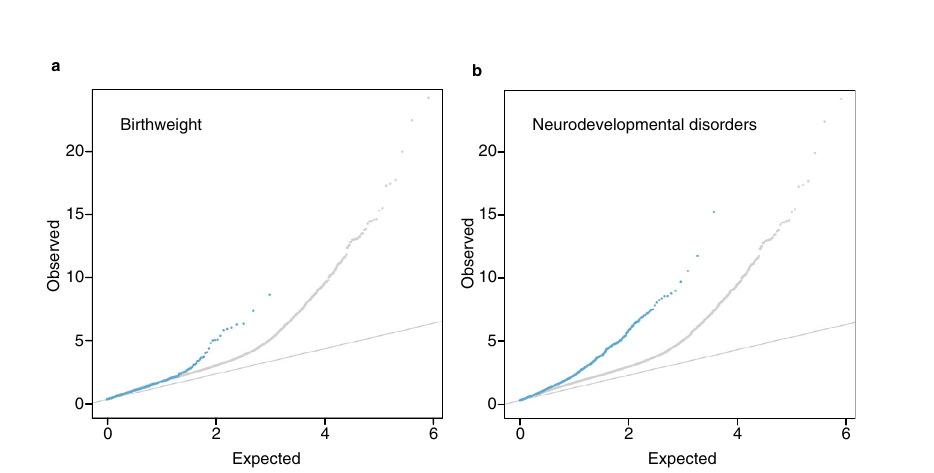
Fig. 7 Differences in DNA methylation between fathers and mothers of naturally conceived and ART-conceived children at the BRCA1-NBR2 locus. In panels ( a – c ), each dot represents the coef fi cient from the regression of DNA methylation on ART-conceived vs naturally conceived newborns, and the vertical bar represents the 95% con fi dence interval. The region shown is chr17:41277059-41278906 (hg19). a 969 fathers for ART-conceived children, 980 fathers for naturally conceived children were examined. The adjusting variables were paternal age, paternal smoking, and paternal BMI. b 970 mothers for ART conceived children, 986 mothers for naturally conceived children were examined. The adjusting variables were maternal age, maternal smoking, maternal BMI before pregnancy, and parity. c 962 ART conceived and 983 naturally conceived newborns were examined. The adjusting variables were maternal age, maternal smoking, maternal BMI before pregnancy, child sex, parity, and plate ID. d The BRCA1 - NBR2 bidirectional promoter showing transcription start and orientation, CpG island (green) and epigenetic marks (purple) representing the site of the promoter (H3K4me3, active promoter; H3K27Ac, active regulatory element; DNA hypersensitive sites (grayscale) open chromatin). e The heatmap shows Pearson ’ s correlation coef fi cients of the DNA methylation across the 34 CpGs within the interval. Source data are provided as a Source Data fi le.